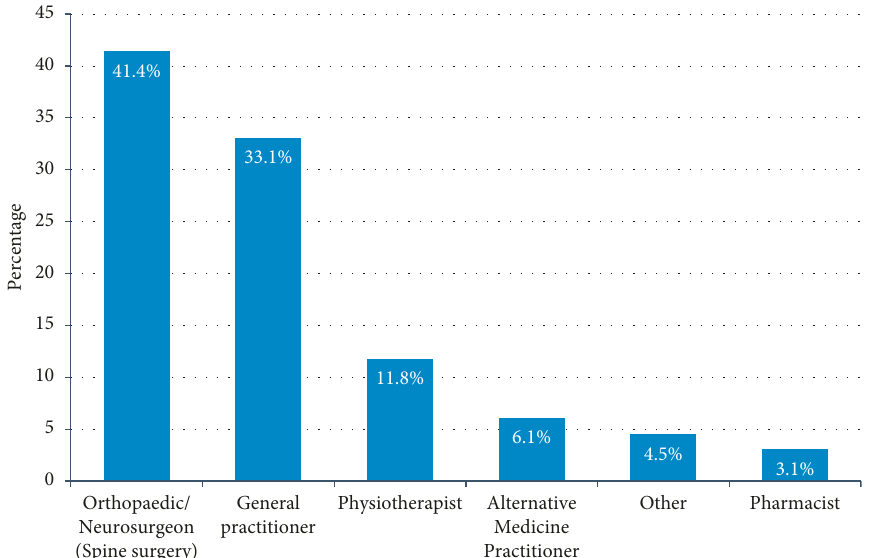
Figure 1: Specialist who provided advice after experiencing sciatica pain.